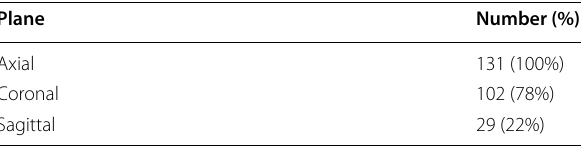
Table 6 Detection of lesions in different planes